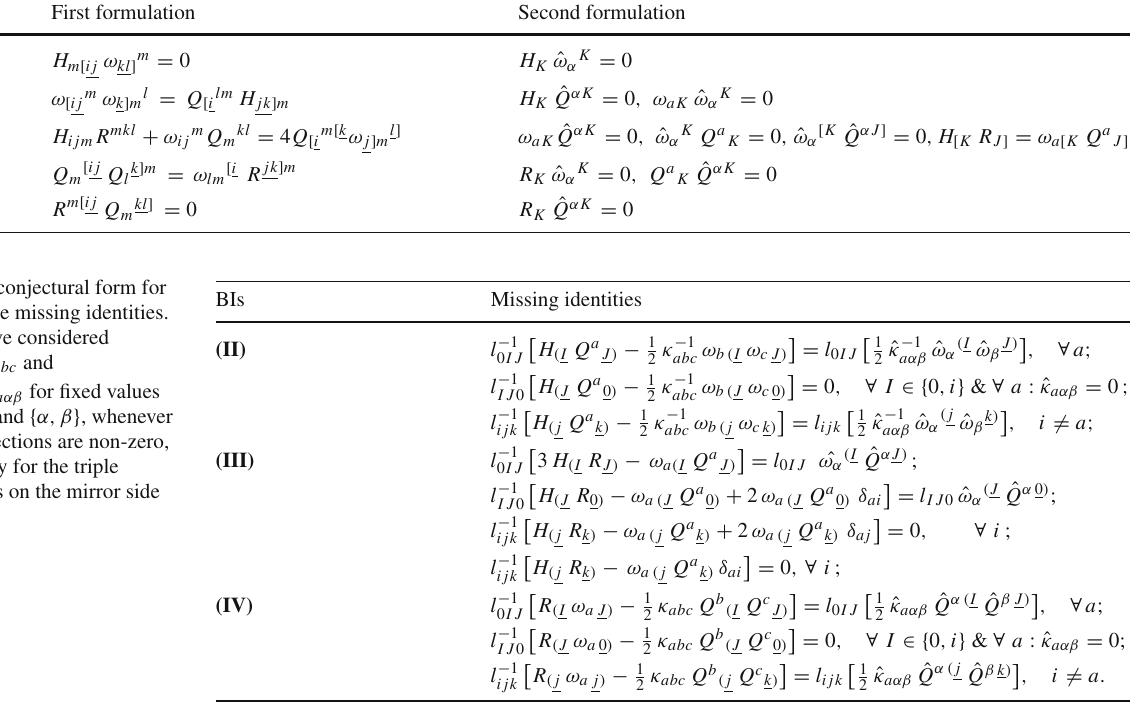
Table 5 Two formulations of the type IIA Bianchi identities BIs First formulation Second formulation